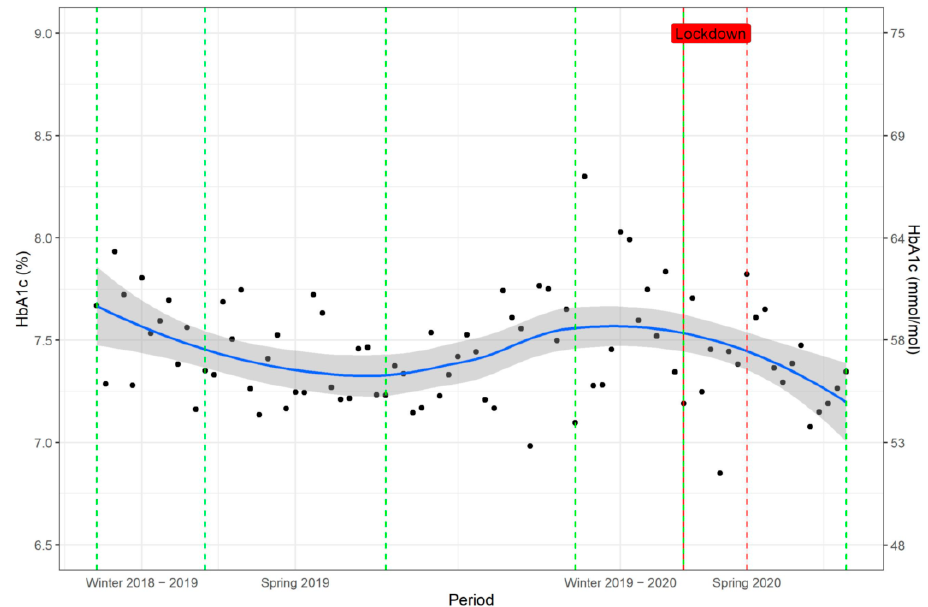
Figure 2. Seasonal variations in HbA1c weekly values in 1078 patients with diabetes mellitus expressed as mean values of HbA1c in observation period 16 December 2018–27 July 2020. The blue line represents the smoothing and the grey field the 95% confidence interval band. Black dots show the mean HbA1c per week. Vertical dashed green lines define the beginning and the end of the individual periods, while the vertical dashed red lines depict the beginning and end of the Swiss national lockdown (the line on the left also defines the beginning of the period Spring 2020).